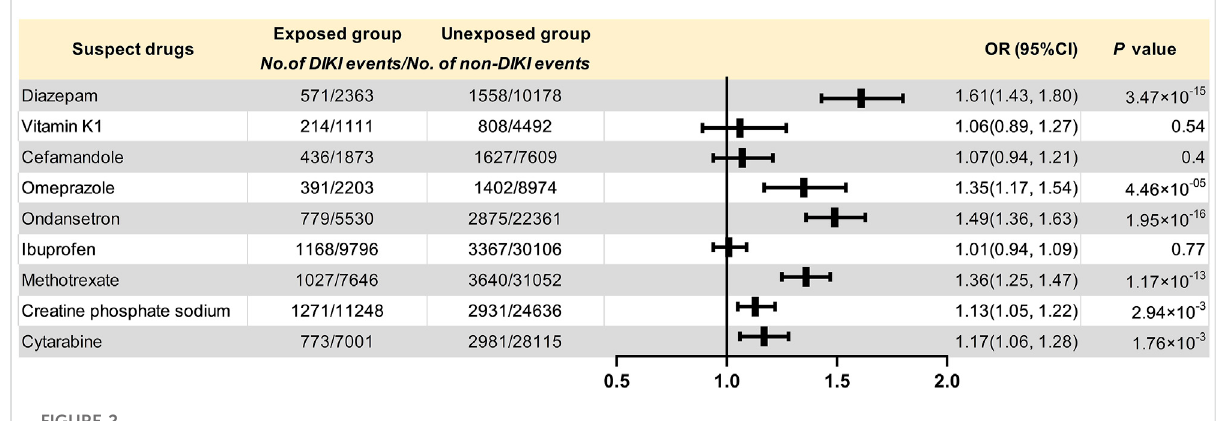
FIGURE 2 Forest plot for the association of suspected drugs with DIKI. Abbreviations: DIKI: drug-induced kidney injury; OR: odds ratio; CI: con fi dence interval.